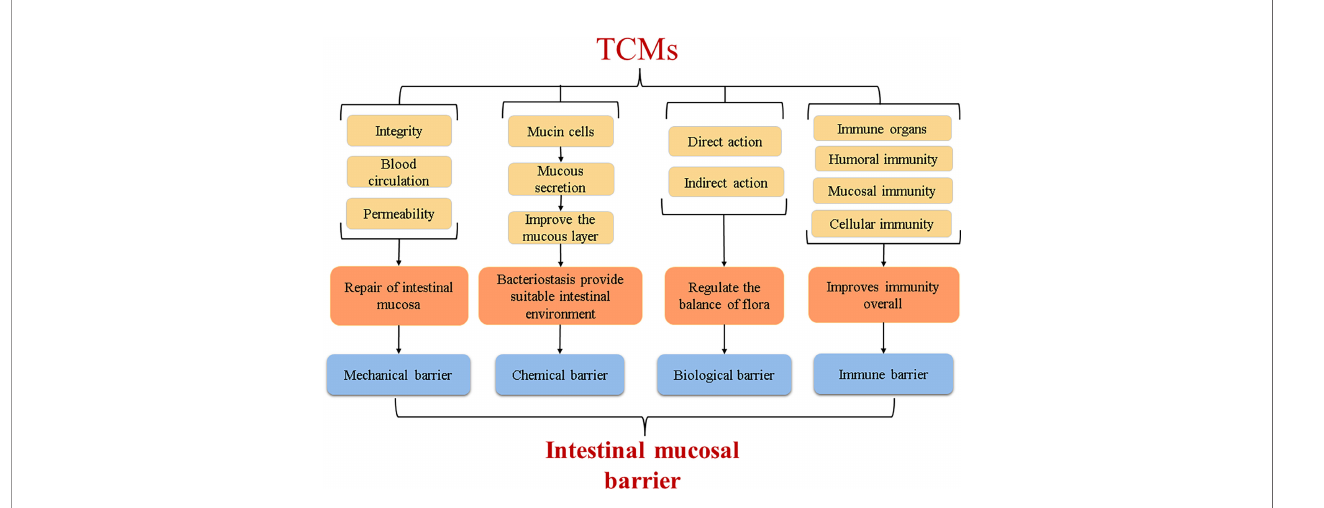
FIGURE 4 | The effect of TCMs on the intestinal mucosal